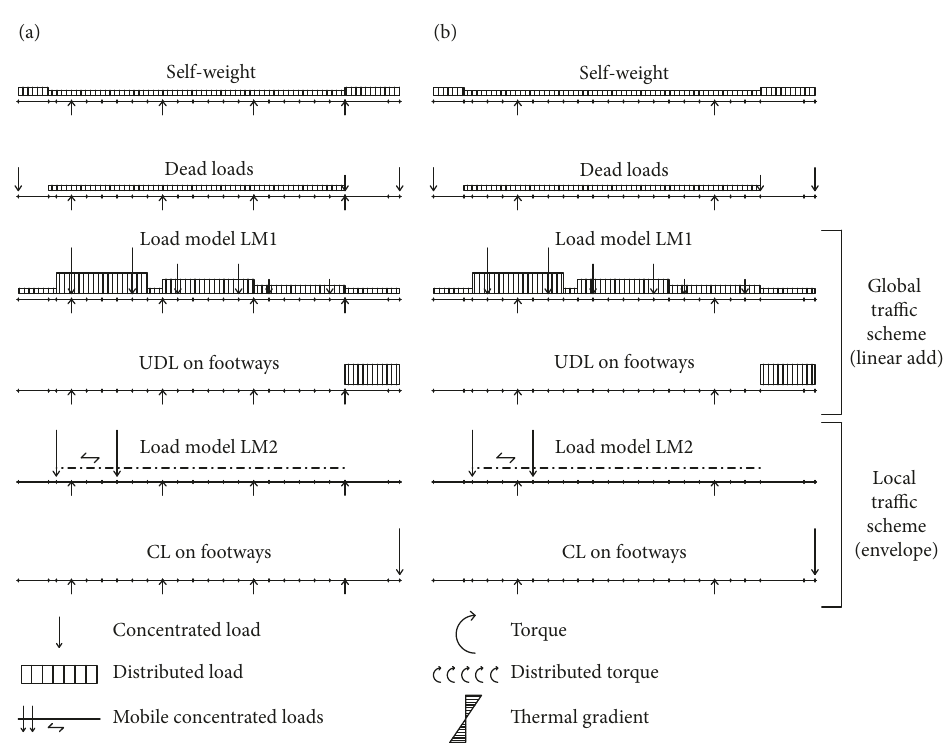
Figure 6: Schematic representation of the applied loads for the deck analysis. (a) Alternative 1: D1. (b) Alternative 2: